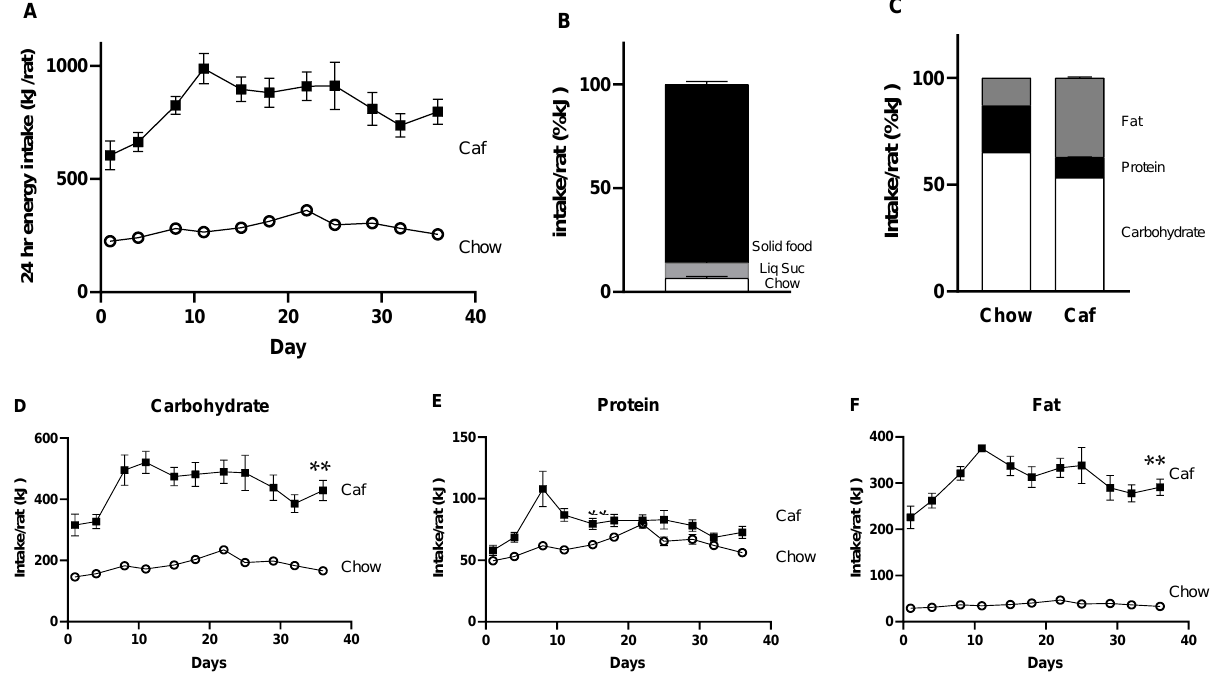
Figure 1. The 24 h energy intake (kJ/rat/day) in chow and Caf rats prior to mating ( A ). Data represent mean ± SEM of 15 chow and 21 Caf females, housed three per cage. Intake of diet component subgroups (chow, solid Caf, and liquid sucrose) in Caf females as percent total kJ is shown in ( B ). Overall macronutrient intake in chow and Caf groups ( C ) as well as macronutrient intake over time ( D – F ) is shown. Data were analysed by mixed ANOVA. ** p < 0.01, significant effect of Caf diet.